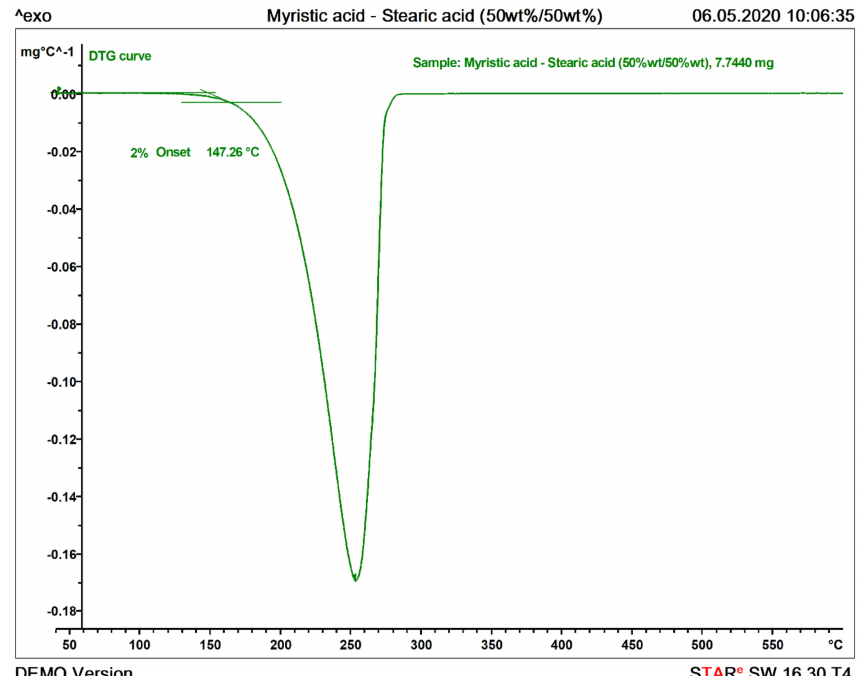
Figure 5. Calculation of the maximum operating temperature on a DTG curve. Maximum operating temperature is defined as the intersection of the tangential line on stable condition (left bound) and the tangential line at 2 % change in mass loss rate (right